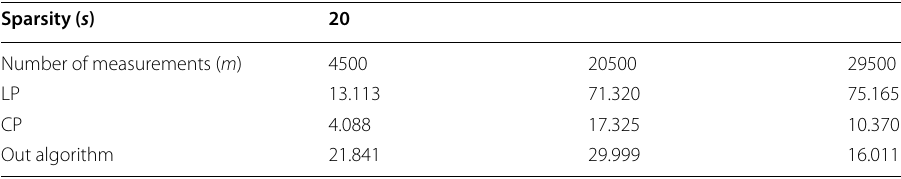
Table 1 Average execution time (millisecond) Sparsity ( s )